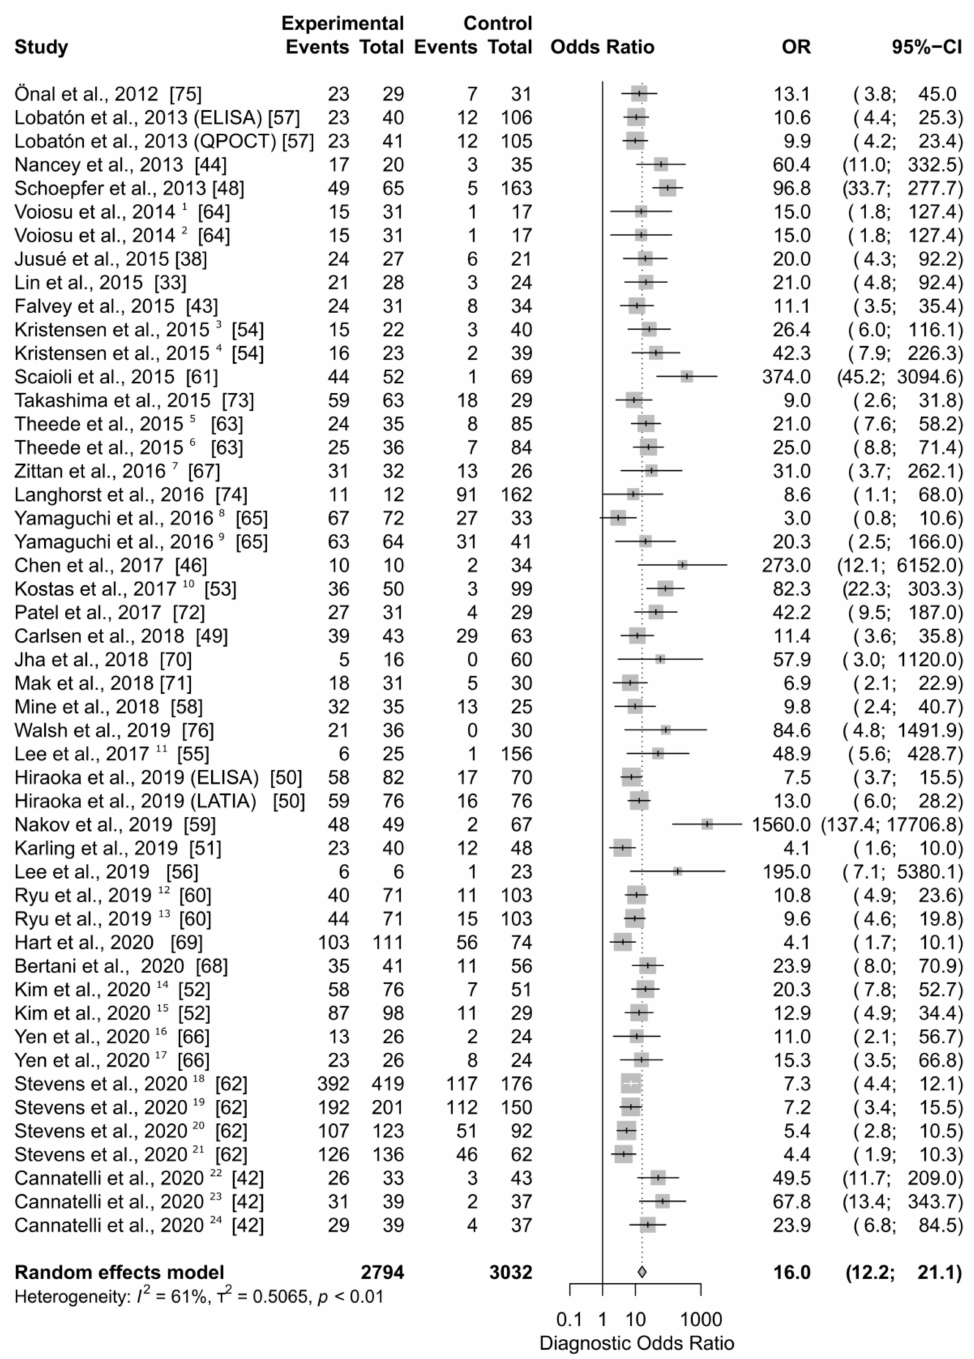
Figure 3. Forest plot of Diagnostic Odds Ratio calculated for the use of FC as the biomarker of mucosal healing in ulcerative colitis. Abbreviations: CI, confidence interval; OR, odds ratio. Notes: Hiraoka et al. compared ELISA and latex agglutination turbidimetric immunoassay (LATIA) kits; Lobat ó n et al. compared ELISA and Q-Point Of Care Test (QPOCT); Further indexed numbers mark different MH definitions: 1 MES = 0; 2 SES-CD ≤ 3; 3 MES = 0; 4 MES ≤ 1; 5 MES = 0; 6 UCEIS = 0; 7 MES = 0 ; 8 MES = 0; 9 MES ≤ 1; 10 MES = 0; 11 MES = 0; 12 MES = 0; 13 UCEIS ≤ 1.; 14 MES = 0; 15 MES ≤ 1; 16 MES = 0; 17 MES ≤ 1; 18 MES ≤ 1 (8 weeks of therapy); 19 MES ≤ 1 (52 weeks of therapy); 20 MES = 0 (8 weeks of therapy); 21 MES = 0 (52 weeks of therapy); 22 MES = 0, 23 UCEIS ≤ 1; 24 modified PICaSSO ≤